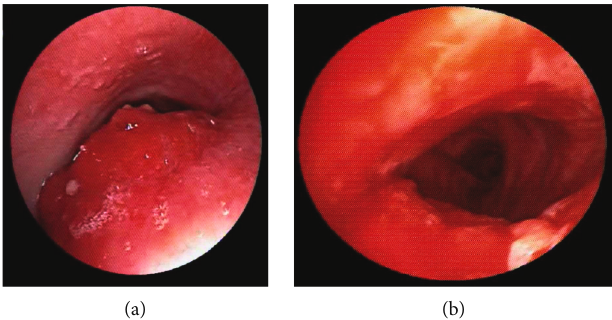
Figure 1: Bronchoscopic fi ndings before and after laser and rigid scope mass removal. (a) In fi ltrative and compression thyroid mass obstructing the tracheal lumen. The distal lesion cannot be seen in this view. (b) Trachea after laser and rigid scope mass